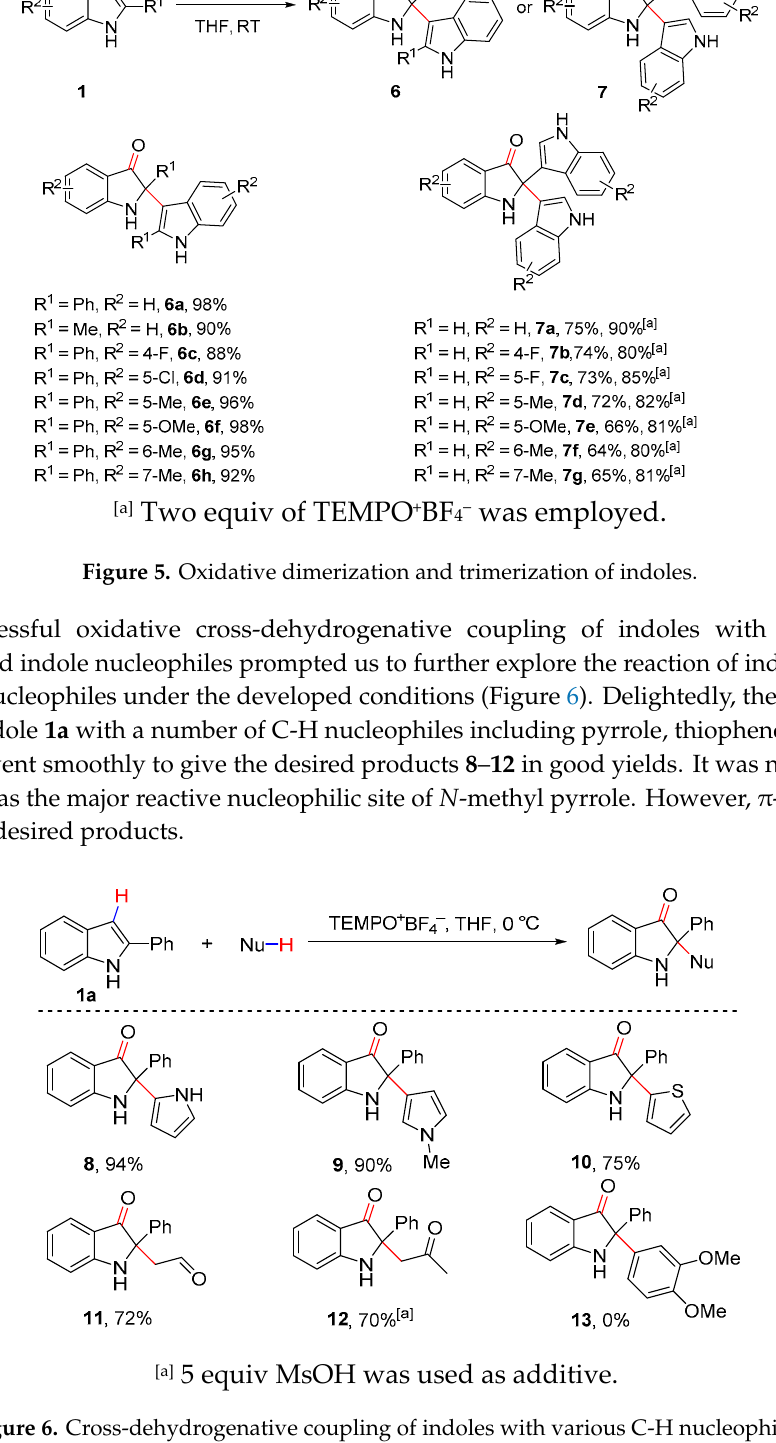
Figure 6. Cross-dehydrogenative coupling of indoles with various C-H nucleophiles.